Question: Identify the chart type used in this figure.
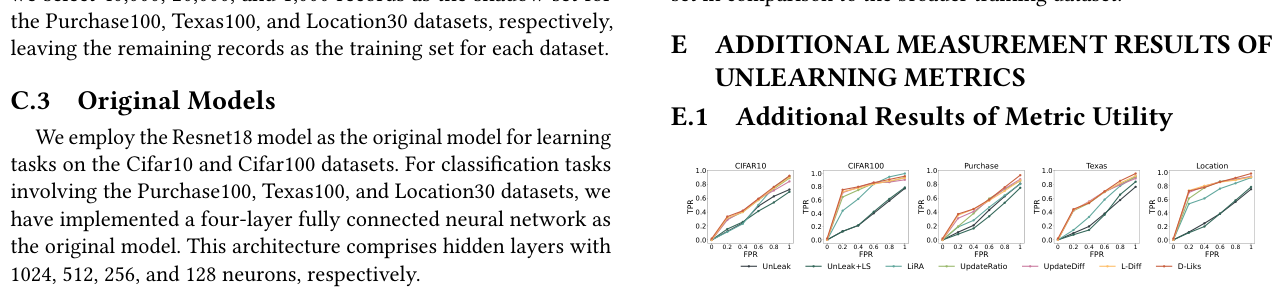
Answer: line